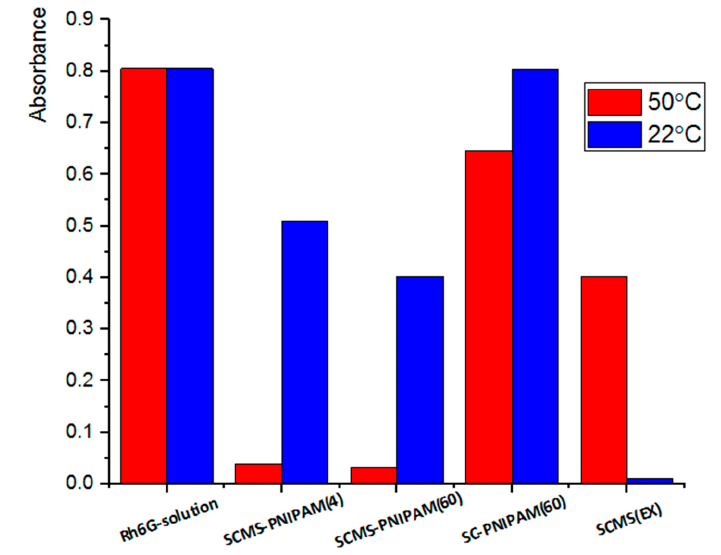
Figure 4. Adsorption of model rhodamine 6G (Rh6G) dye from its solution by various nanoparticles systems as measured by UV / Vis absorption of the supernatant at λ = 527 nm (max. absorbance of